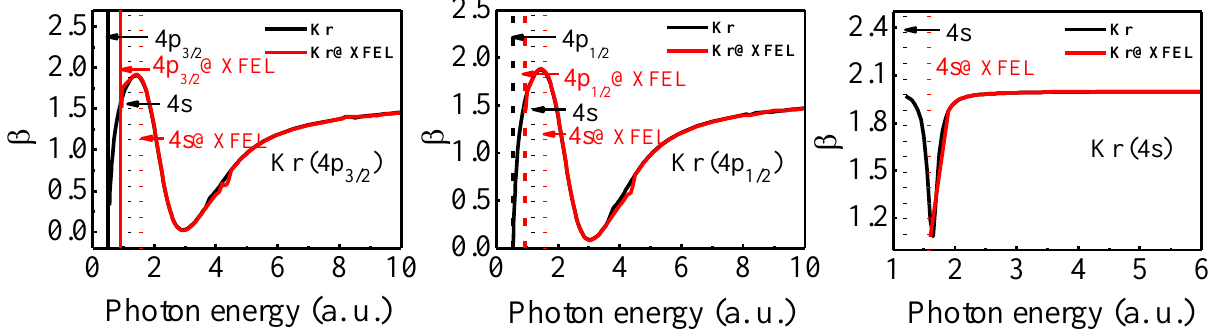
Figure 12. Angular distribution asymmetry parameter ( β ) of 4p 3/2 ( Left ), 4p 1/2 ( Middle ), and 4s ( Right ) subshells of Kr (black) and Kr@XFEL (red). Solid, dashed, and dotted vertical lines represent the threshold for 4p 3/2 , 4p 1/2 , and 4s thresholds of free (black) and confined atom (red), respectively. The average time delay of the 4 p 3/2 , 4 p 1/2, and the 4 s subshells of the Kr and